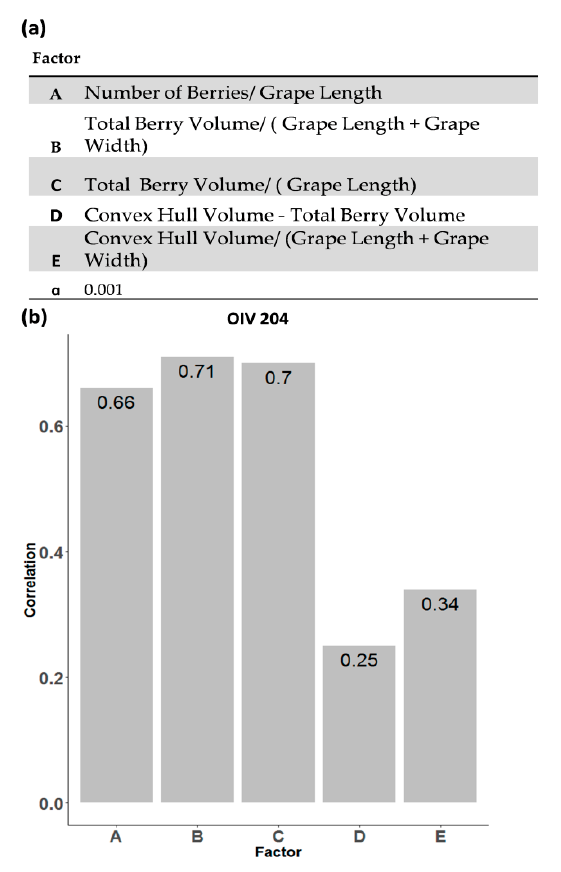
Figure 5. Compactness factors for objective evaluation of OIV 204 descriptor. ( a ) Five factors were estimated from the traits extracted from 3D sensor data ( b ). Correlation values of the factors with OIV 204 descriptor classification. n = 100.